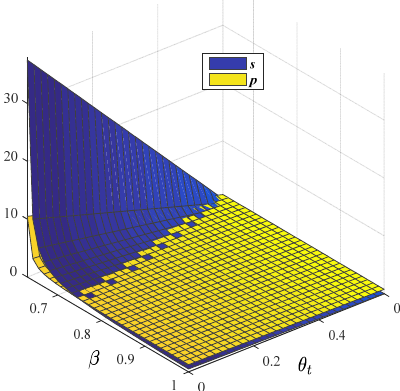
Figure 8. Price and service in Scenario D (1).